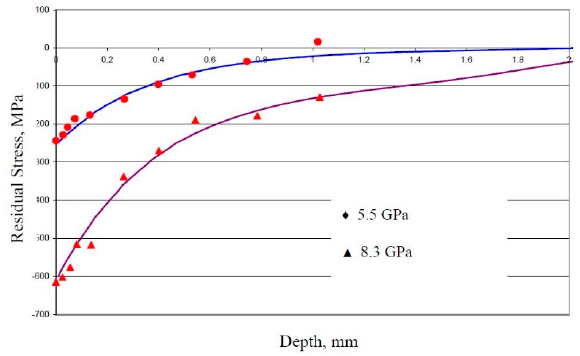
Figure 22. Comparison of experimental and predicted residual stress gradients in Ti-6Al-4V [48,49].